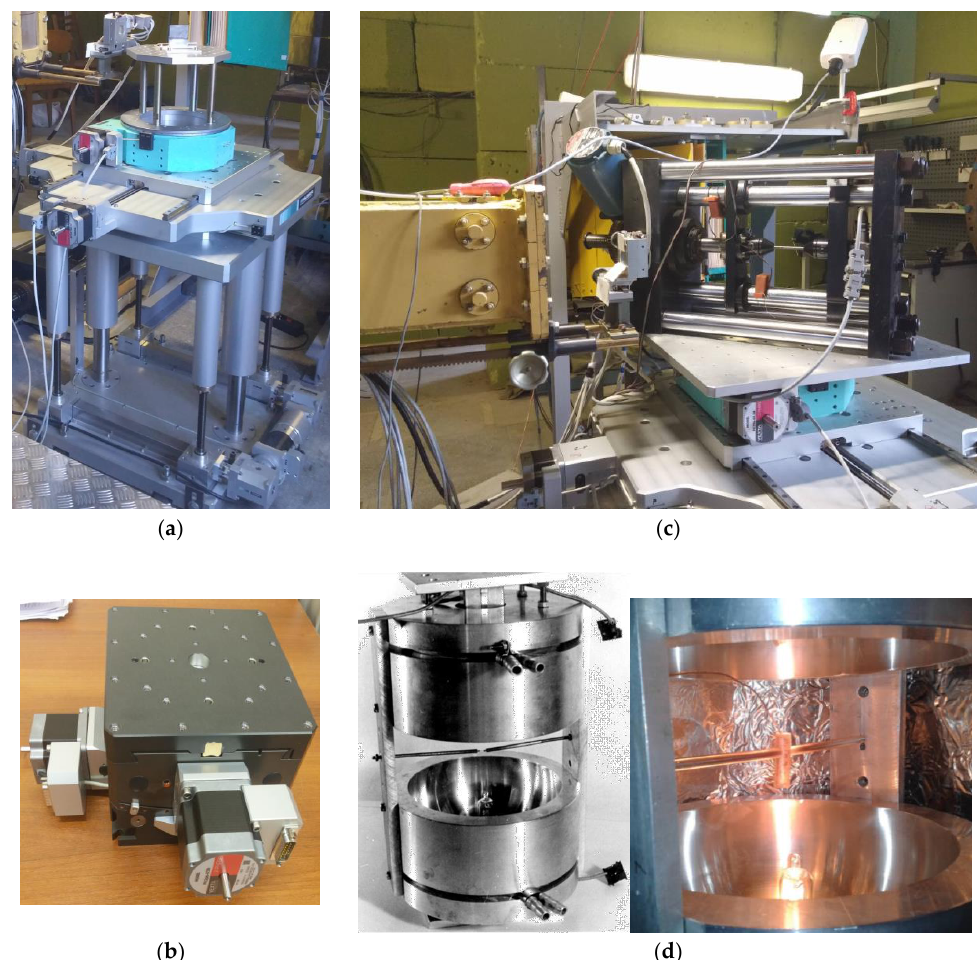
Figure 13. ( a ) Four-axis HUBER goniometer for precise sample positioning (max. load 300 kg); ( b ) Additional goniometer head with ± 15°-tilt; ( c ) Uniaxial mechanical loading machine LM-29 ( F max = 29 kN, T max = 800 °C) installed on the HUBER goniometer during the experiment; ( d ) Water-cooled mirror furnace ( P = 1 kW, T max = 1000 °C). A sample with a thermocouple heated during the experiment is shown.